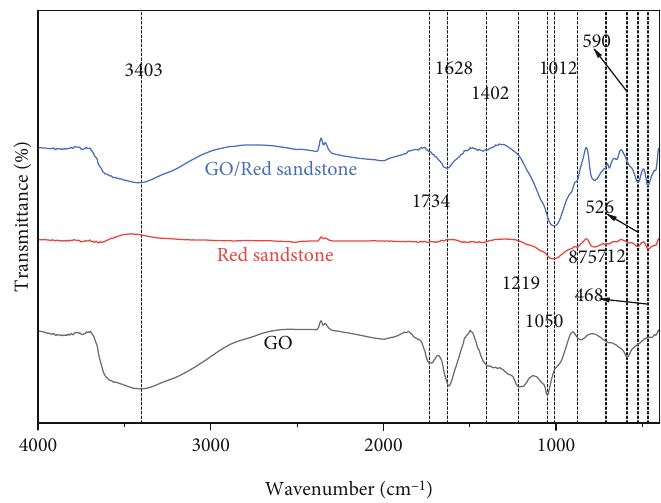
Figure 4: FT-IR analysis of GO, red sandstone, and GO/red